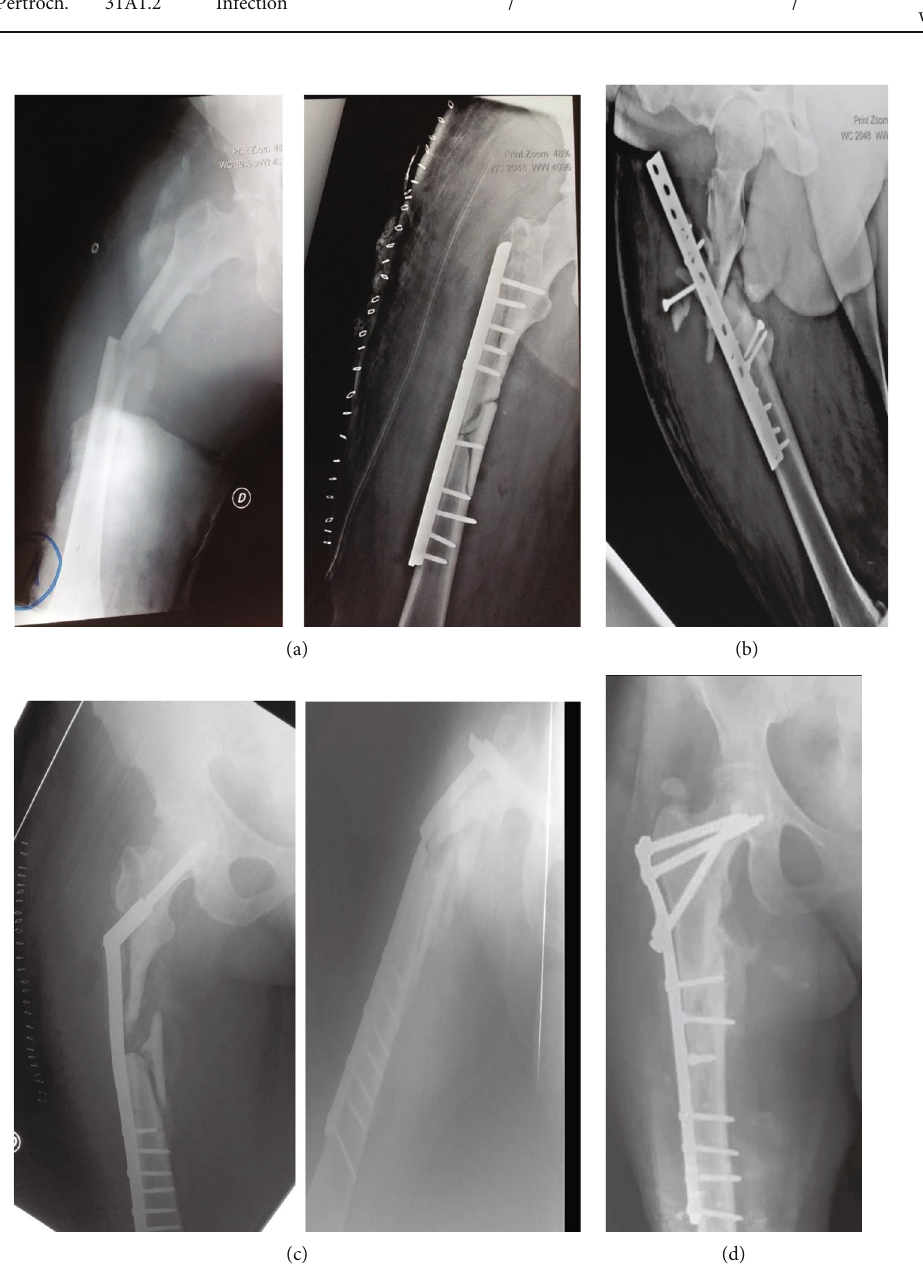
Figure 1: X-ray of case 1: ((a) subtrochanteric fracture; (b) missed fi xation of DCP; (c) atrophic nonunion with fracture of the DHS system; (d) locked plate